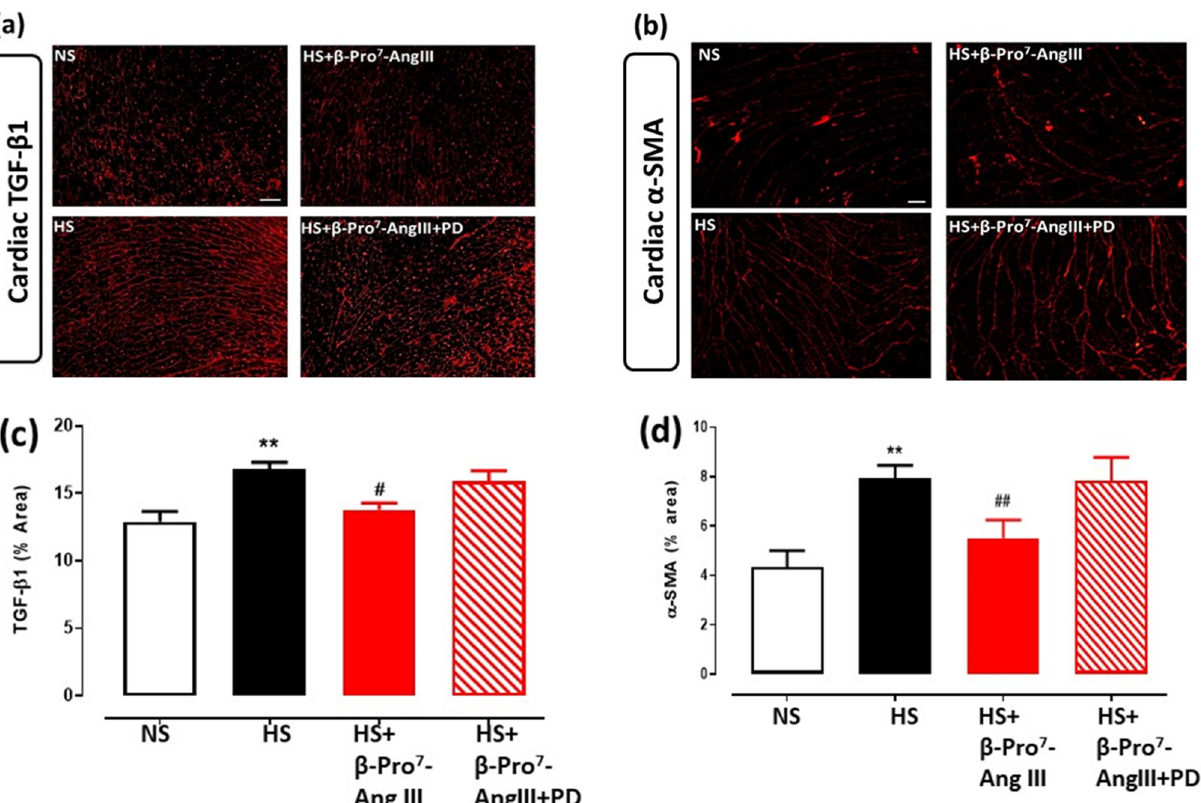
Figure 3. Representative images for ( a ) TGF- β 1 and ( b ) α -SMA in cardiac sections obtained from male FVB/N mice fed on a normal salt (NS, 0.5% NaCl) diet or mice fed on a high salt (HS, 5% NaCl) diet in the presence or absence of β -Pro 7 -AngIII (0.1 mg/kg/day) +/ − PD123319 (1 mg/kg/day). Scale bar for all images = 50 µ m. Group data of % area of ( c ) TGF- β 1 and ( d ) α -SMA in cardiac sections (n = 7–8 per group). All data are expressed as mean ± s.e.m. ** p < 0.01 vs. sham; # p < 0.05, ## p < 0.01 vs. HS, determined by One-Way ANOVA with Tukey correction for multiple comparisons.